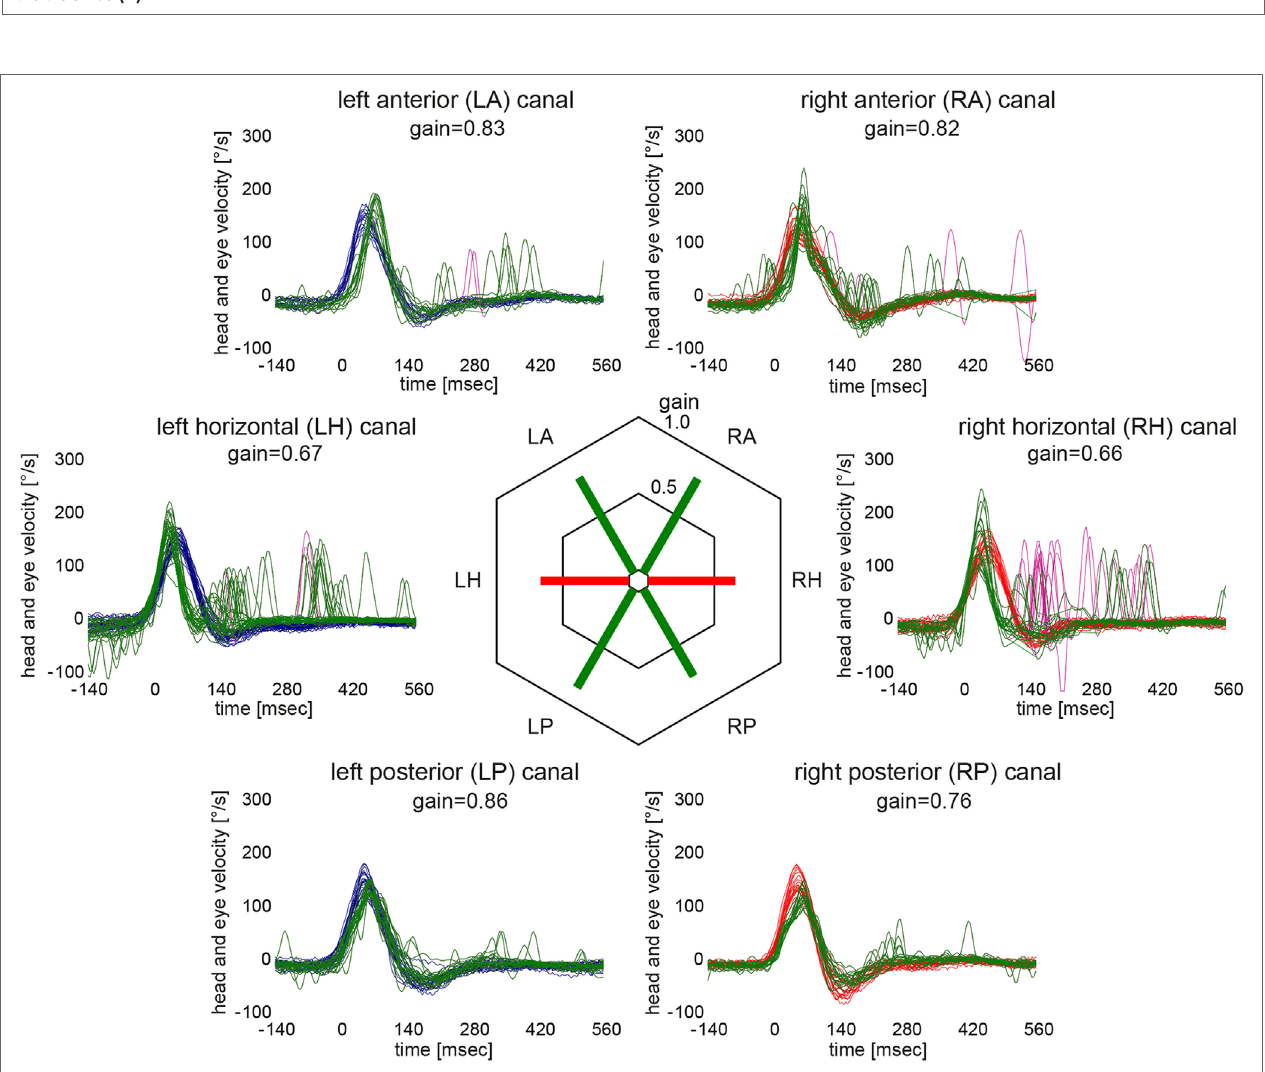
FigUre 2 | Video head-impulse testing from the same patient as in Figure 1 (patient #1) 12 days after symptom onset illustrating semicircular canal impairment restricted to the horizontal canals. For each semicircular canal, individual eye velocity traces (in green) and head velocity traces (in red for assessing the right vestibular organ and in blue for assessing the left vestibular organ) are plotted against time (20 trials per canal were recorded). Note that eye velocity traces are inverted to allow for better visualization and comparison with the head velocity traces. Mean gain values (eye velocity/head velocity) are shown in the hexagonal plot in the center of the figure. Whereas green bars indicate normal gains, red bars refer to reduced gains.